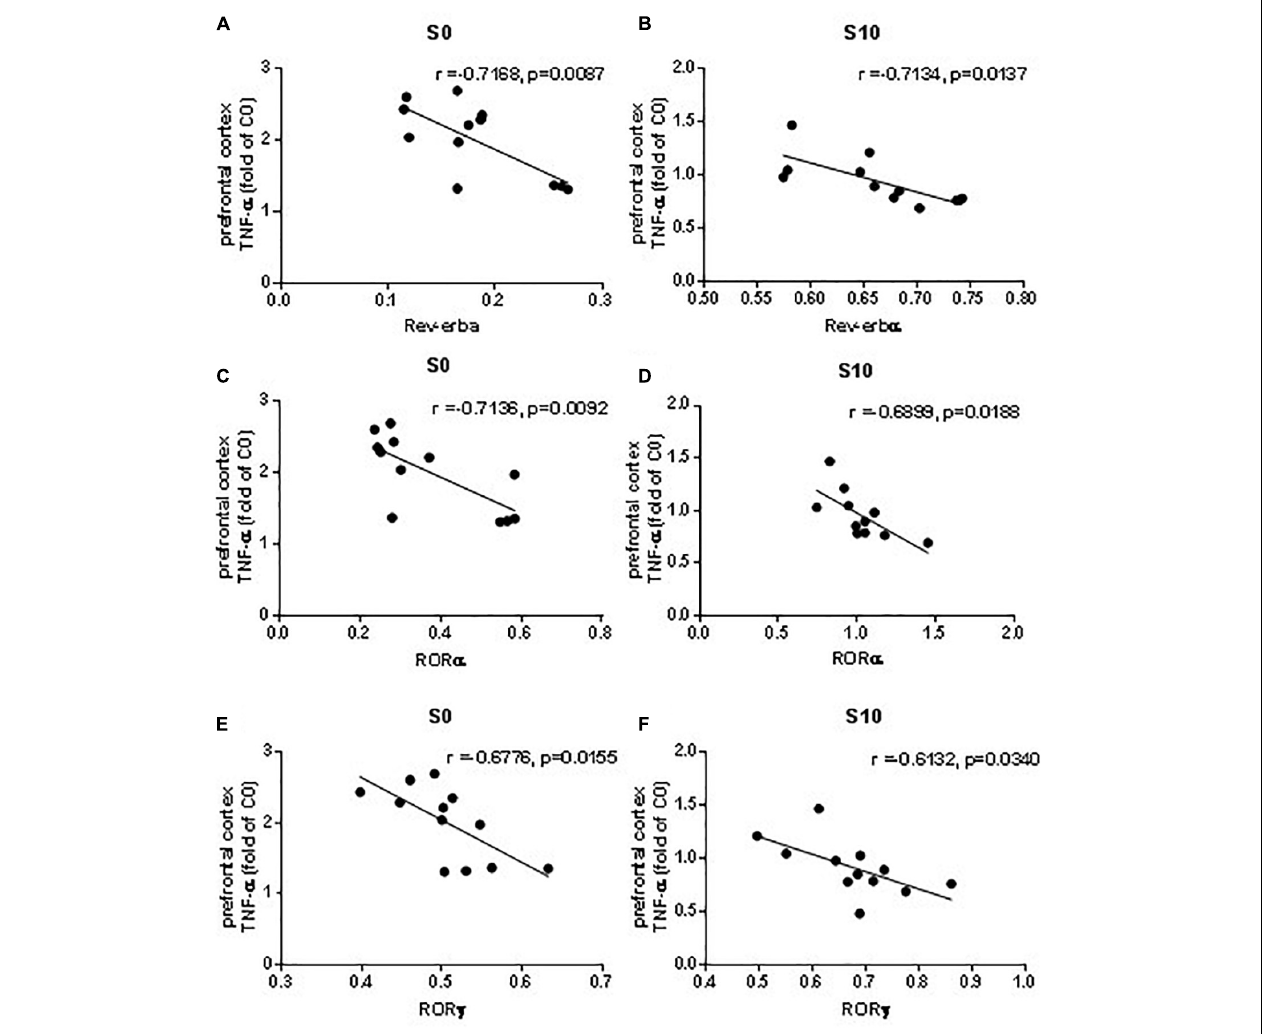
FIGURE 8 | Linear regression analysis between mRNA levels of clock genes Rev-erb α , Ror α and ROR γ and proinflammatory cytokine TNF- α in the prefrontal cortex induced by exploratory laparotomy. The mRNA level of Rev-erb α (A) , Ror α (C) and ROR γ (E) in the surgery group with vehicle pretreatment correlated with TNF- α . The mRNA levels of Rev-erb α (B) , Ror α (D) and ROR γ (F) in the surgery group with NOB 10mg/kg pretreatment correlated with TNF- α . n =